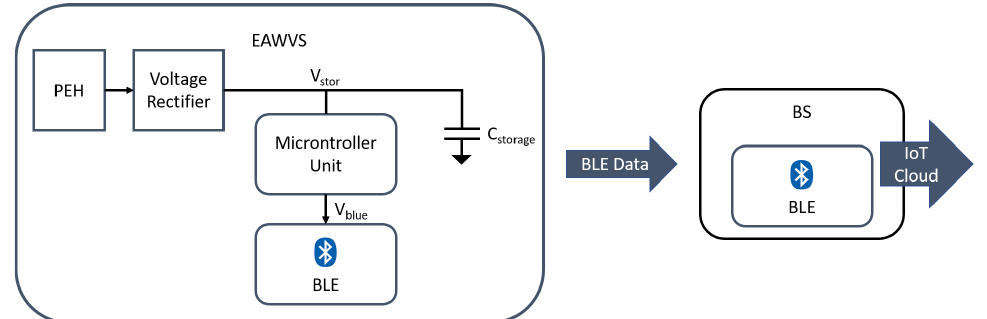
Figure 1. System block diagram